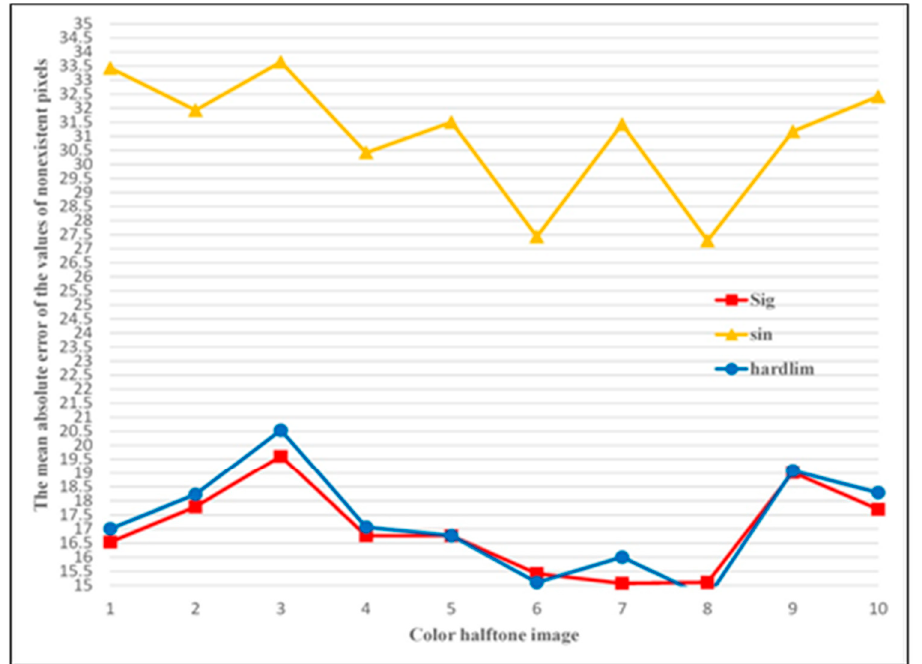
Figure 4. The influence of activation function in ELM algorithm on null-value approximation.